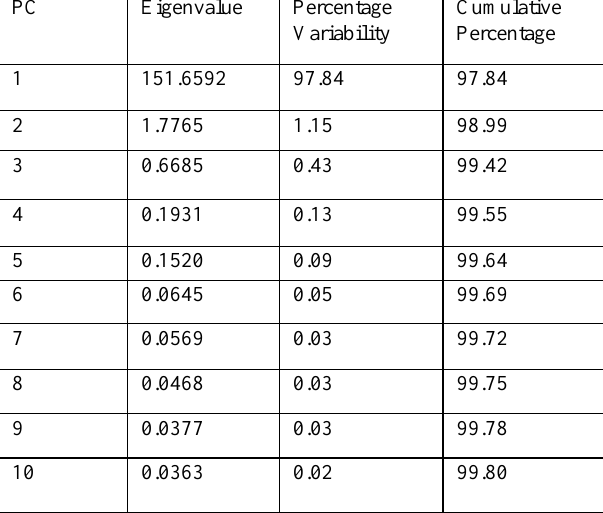
Table 1. Percentage Variability, Cumulative Percentage of